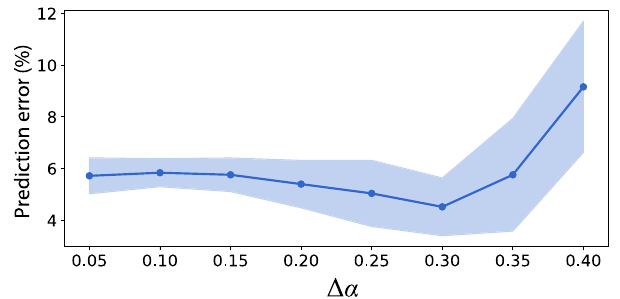
FIG. 3. Prediction error for misidentification of communities in the reconstructed cat cerebral cortex from synthetic data. For each realization, the chosen parameters are the same as in Fig. 1 and only the overall coupling is changed. Mean and standard deviation of prediction error computed for the network over 50 realizations for each value of α . If Δ α > 0 . 42 , the system synchronizes and the procedure cannot reconstruct the commu- nity structures.